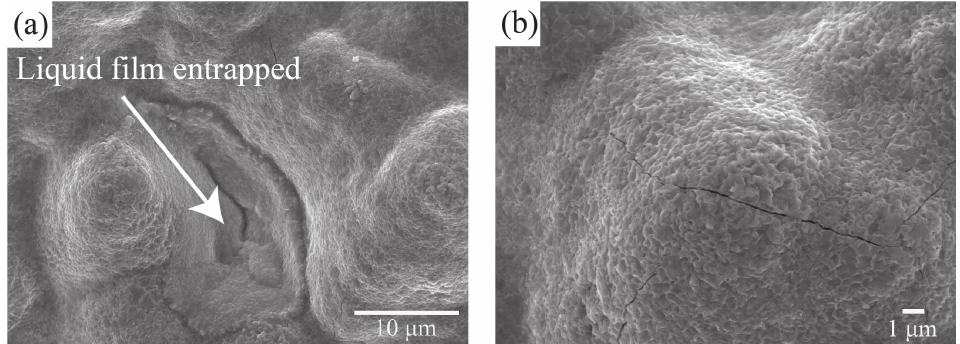
Figure 9. Micrographs of the fracture surface of TRIP steel (5mm case). ( a ) Liquid film entrapped between dendrites that lead to cracking and ( b ) micro-cracks on the dendrite